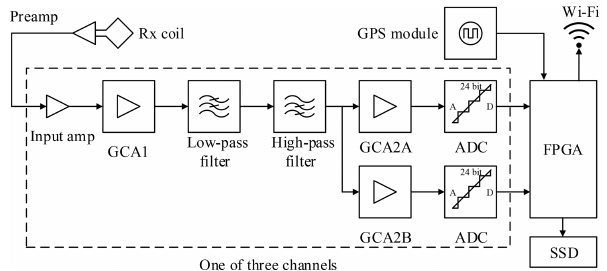
Figure 3. Block diagram of acquisition board. Note that each Ap- suRx contains three duplicated channels, and only one of them is illustrated in the dashed